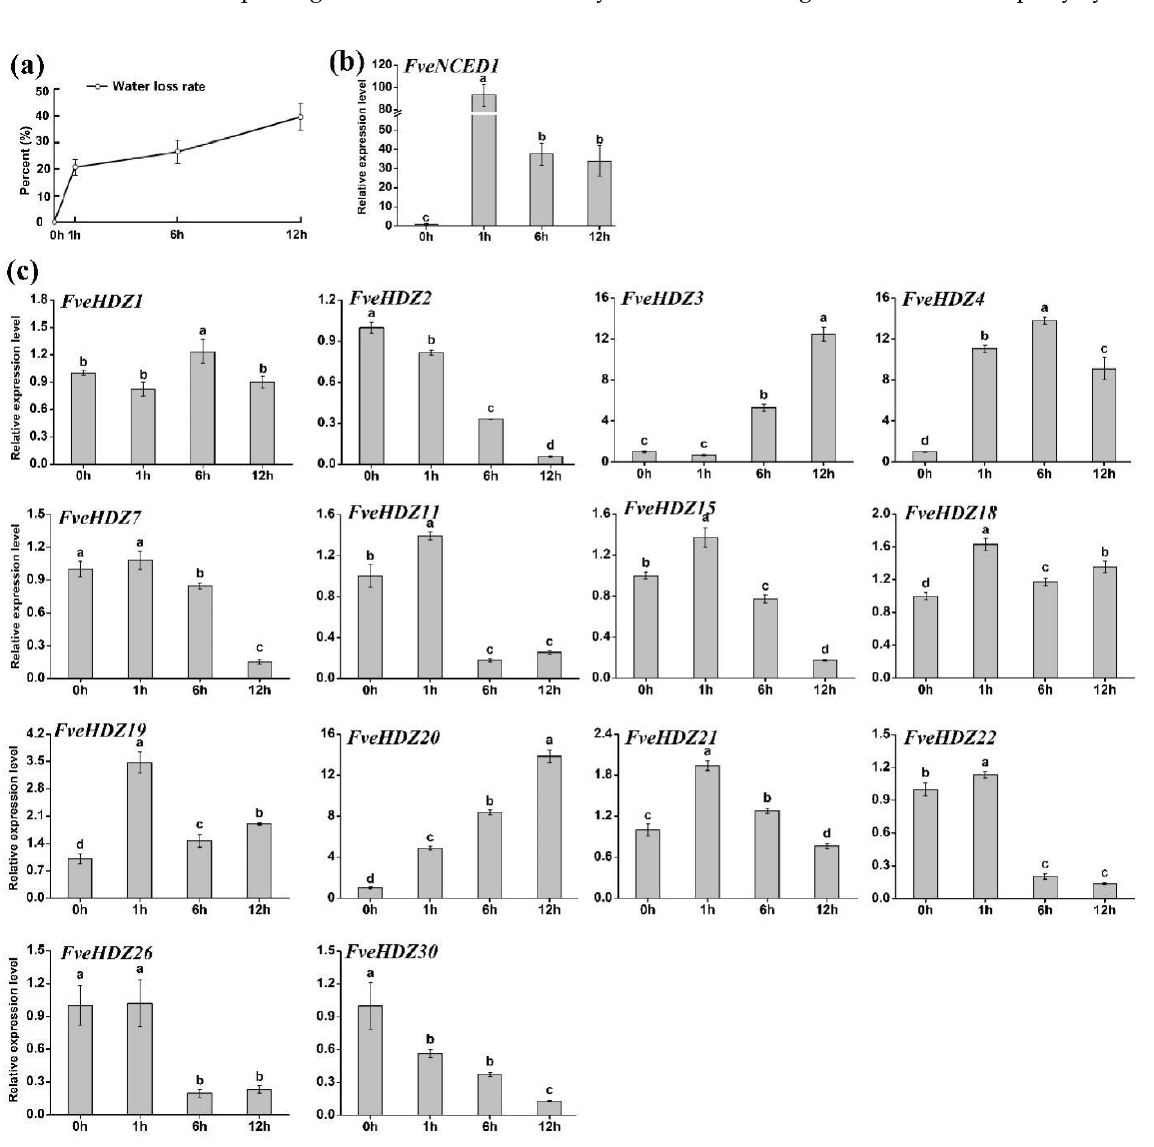
Figure 6. Water loss and relative gene expression levels during leaf dehydration. ( a ) The water loss rate of the dehydrating leaves. ( b ) Relative expression levels of FveNCED1 ( FvH4_3g16730 ), the key ABA synthesis gene in response to drought stress [45]. ( c ) Relative expression levels of FveHDZs . Expression at 0 h was normalized as “1” for each gene. Data were shown as mean ± standard deviation derived from three biological replicates, and different letters above the bars indicate significant differences based on Duncan’s multiple range tests ( p < 0.05, n = 3).